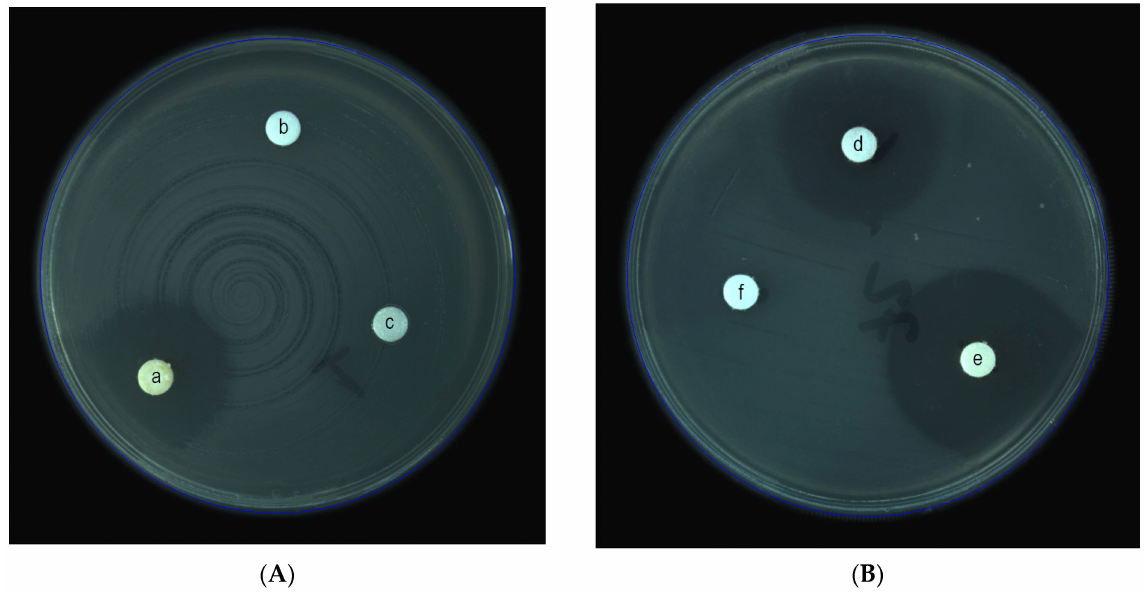
Figure 1. ( A , B ) Representative images for Kirby–Bauer disk diffusion screening results, showing the zones of inhibition: (a,e) Cinnamomum zeylanicum ; (b,c,f) Origanum vulgare , Melaleuca alternifolia , respectively Curcuma longa ; (d) Thymus vulgaris